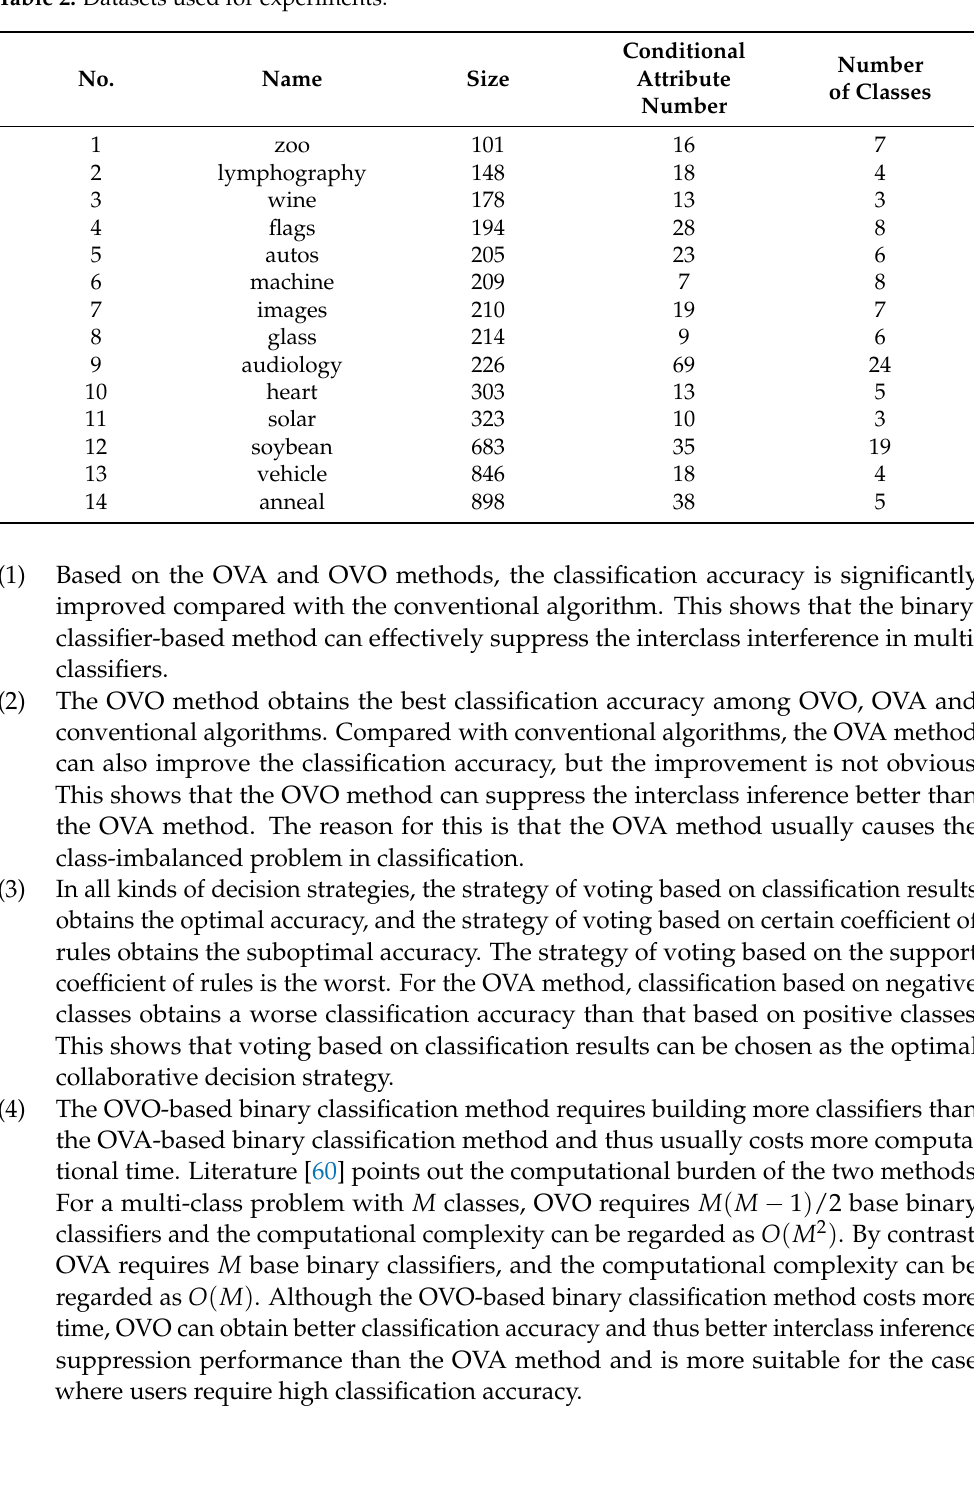
Table 2. Datasets used for